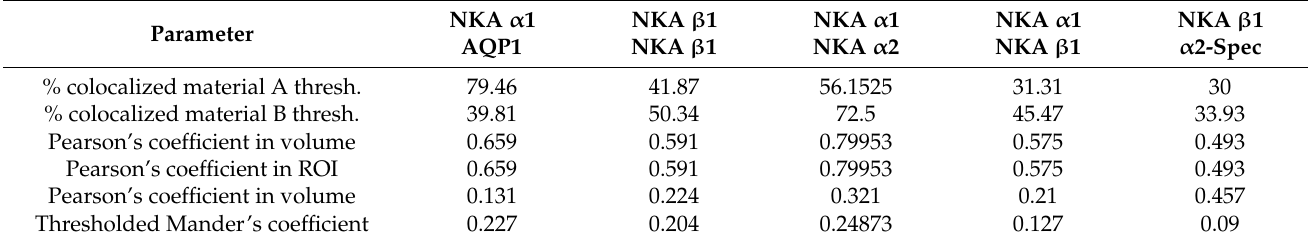
Table 3. Co-localization analysis of STED images (NKA: Na,K-ATPase, Spec: